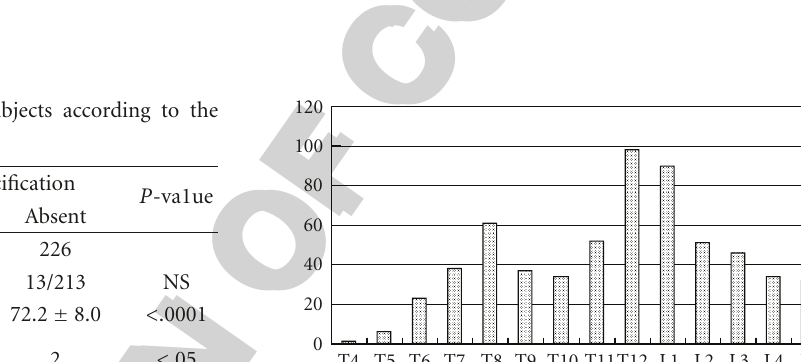
Figure 1: Radiographs (lateral views) of the thoracic and lumbar spine in a man (a) and a woman (b). Abdominal aortic calcification is prominently displayed on routine lateral lumbar spine radiographs as the dense calcium mineral deposits in the aorta of subjects with osteoporotic vertebral fractures.